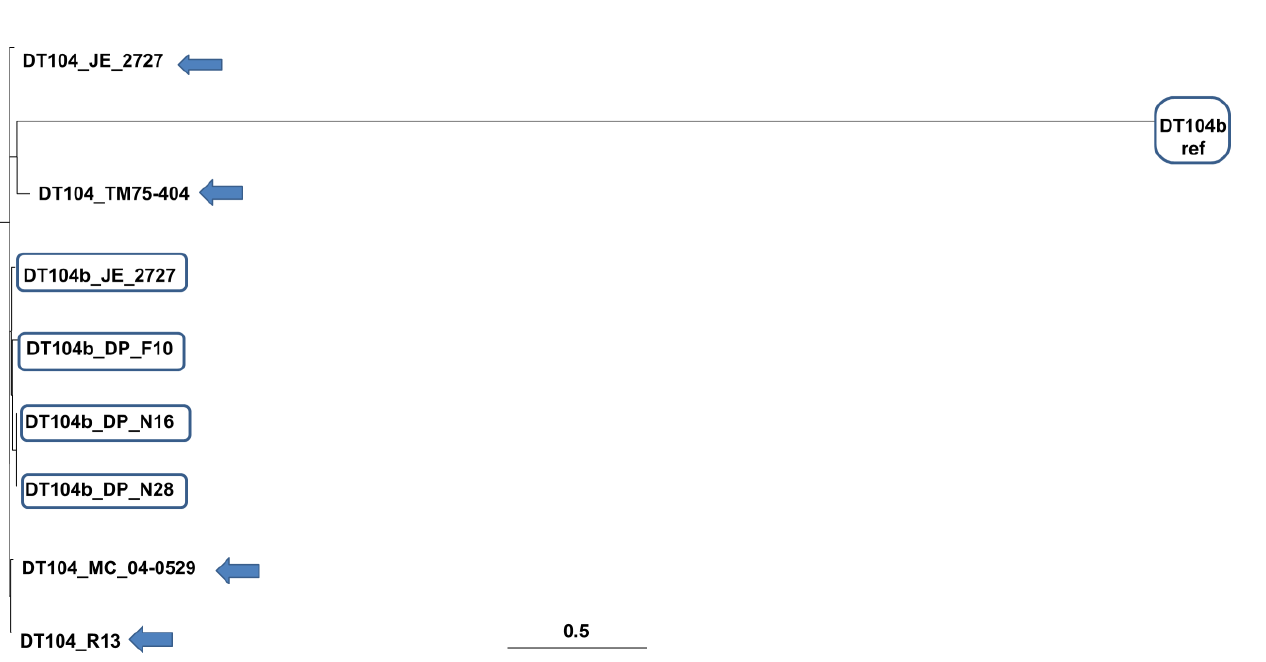
Figure 1. Maximum likelihood (ML) phylogenetic tree based on single nucleotide polymorphisms (SNPs) determined from the whole genome Scheme 2. DT4 was used as a reference strain to construct the tree. The tree shows a close relation among DT104 strains (with arrows) and DT104b strains (boxed) with no significant divergence among them. Table 3. SNP distance matrix among the S. Typhimurium genomes. The SNP differences between each pair of S. Typhimurium were determined by the CSI Phylogeny 1.4 tool [16].